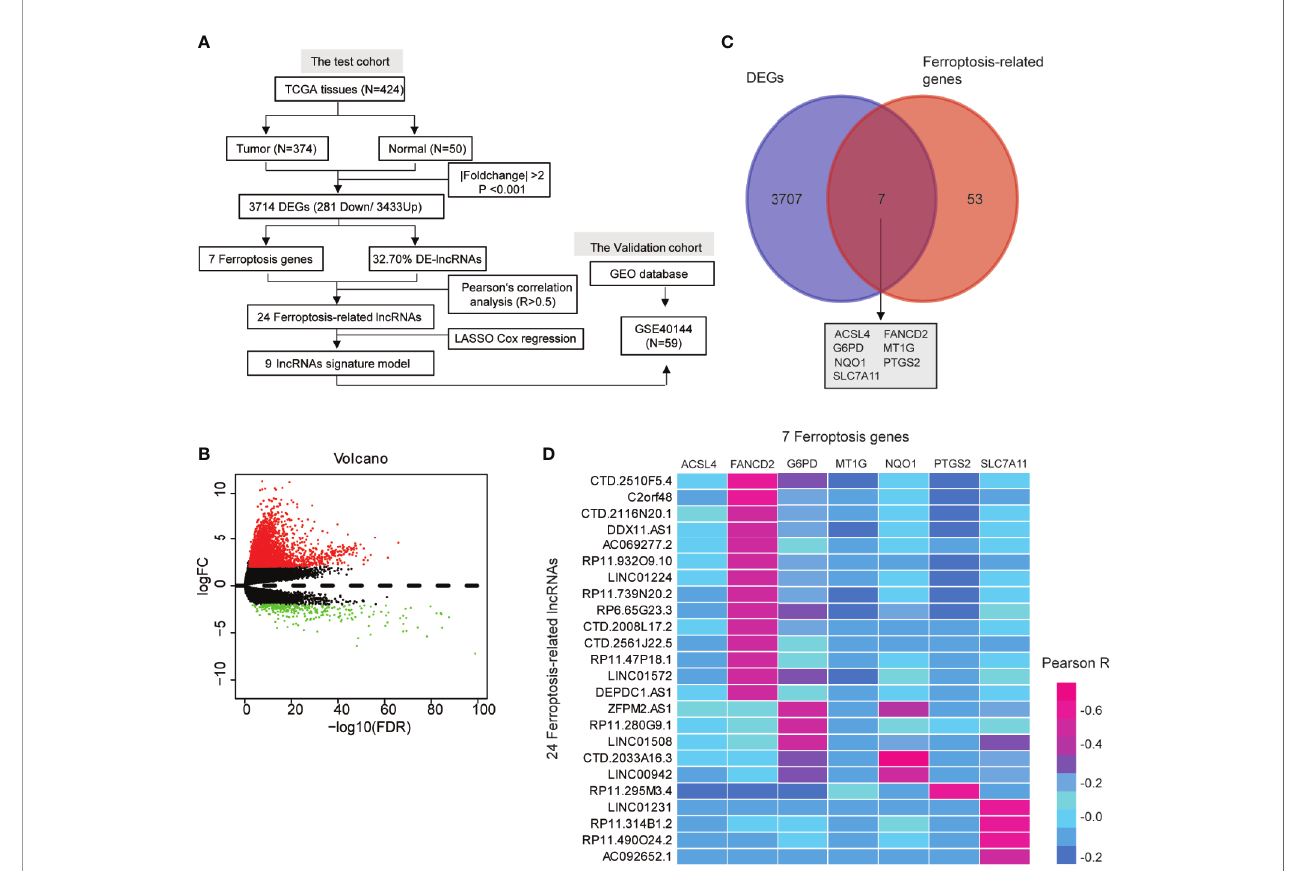
FIGURE 1 | A screen of the differentially expressed ferroptosis-associated lncRNAs in hepatocellular carcinoma (HCC). (A) Flow chart of the analytical process in this study. (B) Volcano plot representing the differentially expressed genes (DEGs) between the normal and the HCC groups. The upregulated and downregulated DEGs are highlighted in red and green, respectively. (C) Venn diagrams of the differentially expressed ferroptosis-related genes. (D) Heat map showing the Pearson ’ s correlation between the differentially expressed-lncRNAs and the differentially expressed ferroptosis-associated